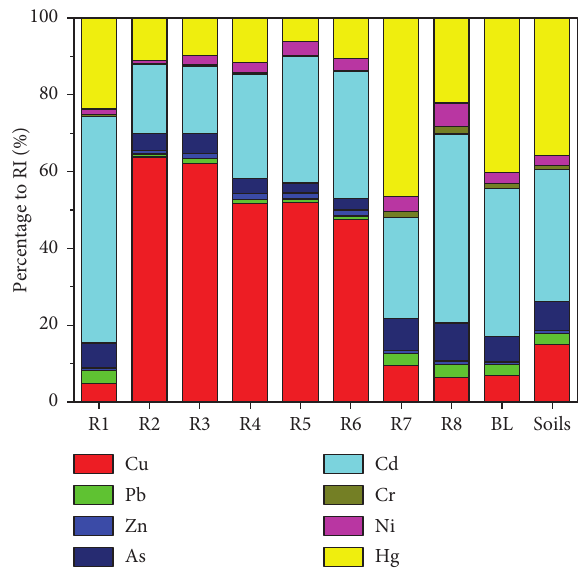
Figure 6: Contribution percentage of each heavy metal to